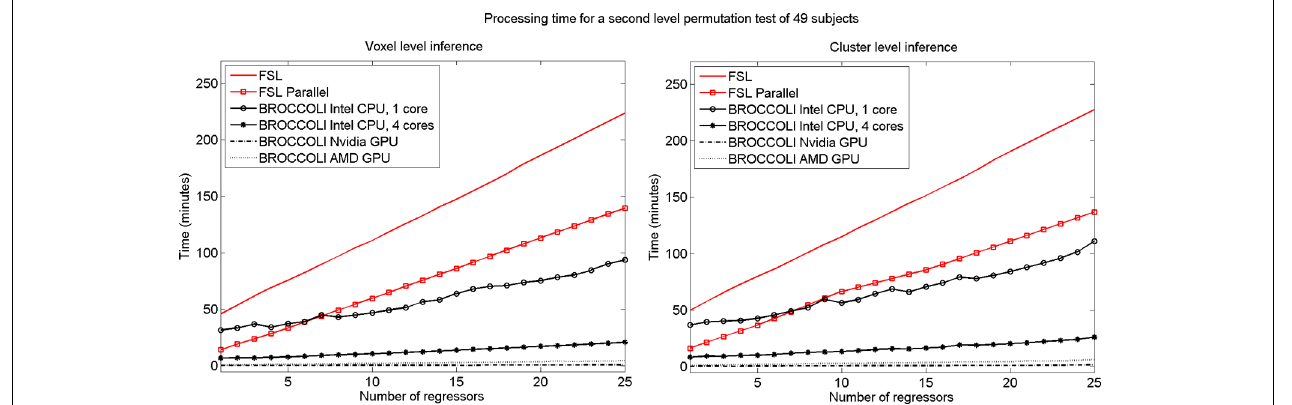
FIGURE 13 | Processing times for second level analysis using a permutation based t -test with 10,000 permutations, for BROCCOLI and FSL (the SPM and AFNI software packages do not provide any functions for permutation based analysis). Left: Voxel-level inference, the maximum t -test value is saved in each permutation. Right: Cluster-level inference, the extent of the largest cluster is saved in each permutation. A t -value of 3 was used as a cluster defining threshold. The data used are beta volumes from 49 subjects, where each beta volume is of the size 91 × 109 × 91 voxels. A brain mask was used to only perform the statistical calculations for the brain voxels. The processing time for FSL increases quickly with the number of regressors, while the processing